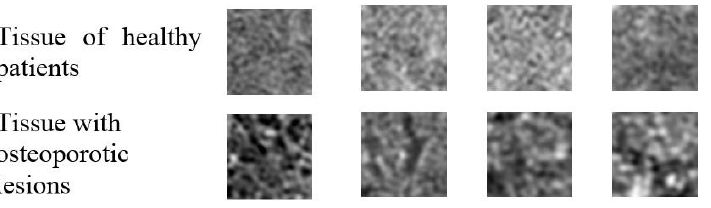
Figure 3. Image samples of healthy patients’ tissue and tissues with osteoporotic lesions in their original size.